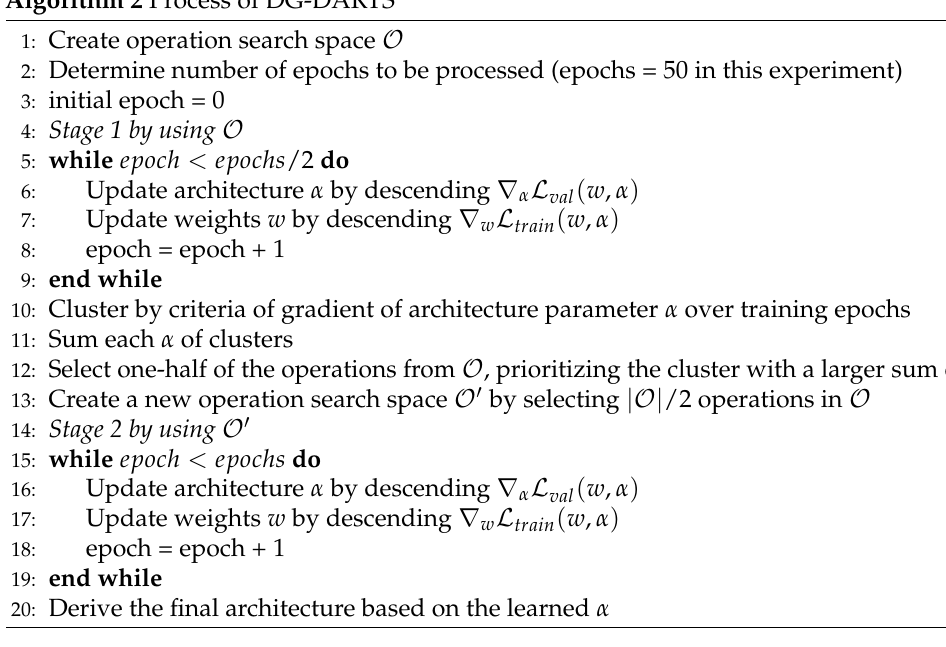
Figure 1. Process of architecture search with multiple search stages. Algorithm 2 Process of